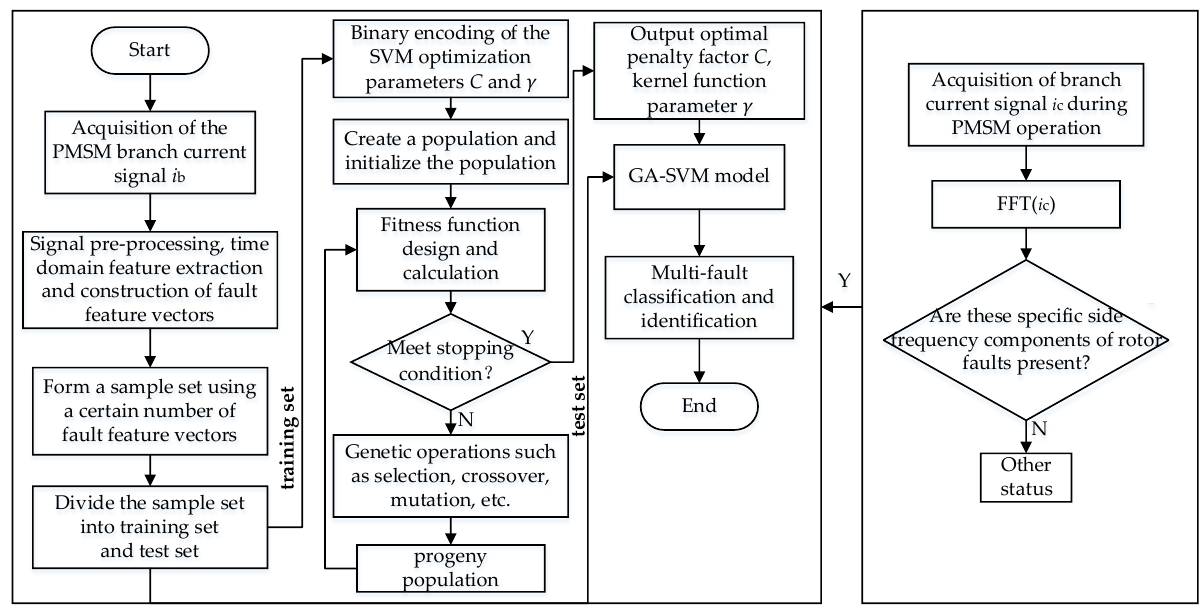
Figure 9. GA-SVM model for rotor fault diagnosis and identification of